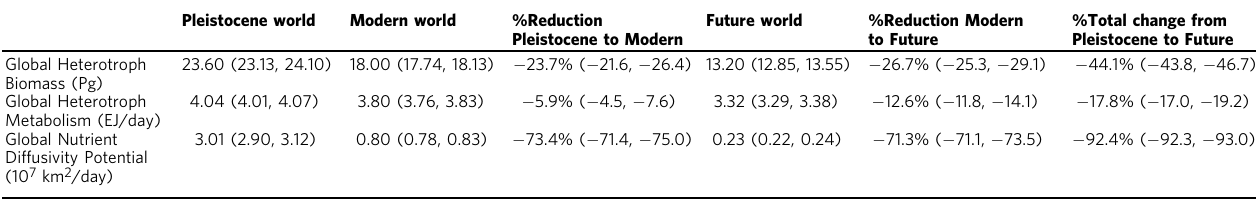
Table 1 The global total of the three-heterotrophic ecosystem-level